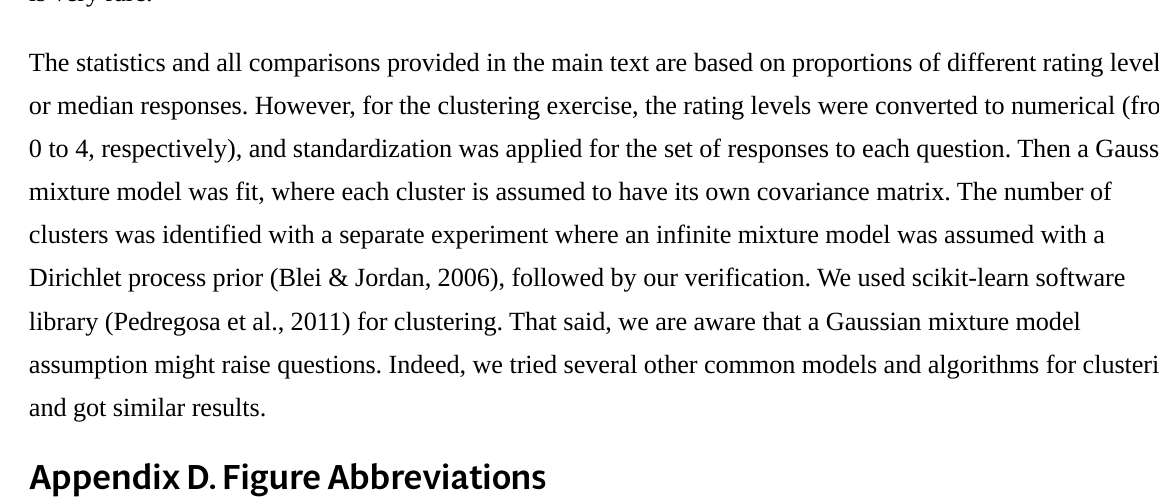
Figure 2. Median responses of the identified data science unicorns to the questionnaire items in comparison with the rest of self-declared data scientists.